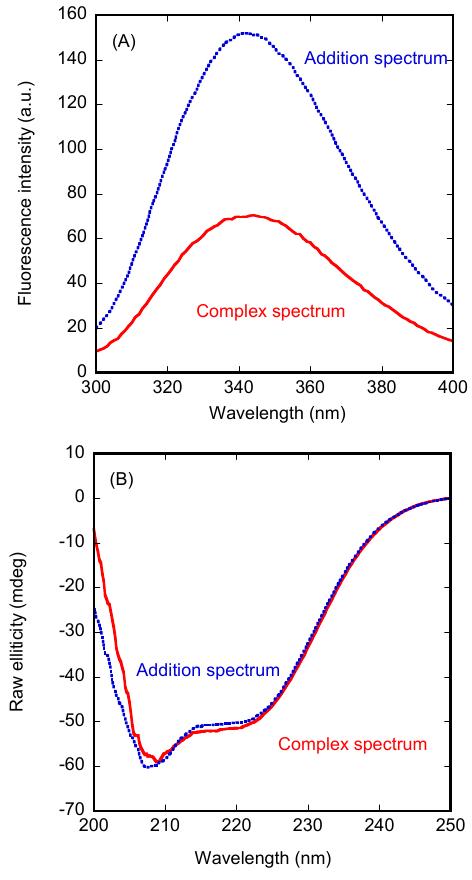
Figure 1. Binding of Imp α 3 to PADI4 as monitored by spectroscopic probes. ( A ) The spectrum of PADI4/Imp α 3 complex after excitation at 280 nm, and the addition spectrum obtained by the sum of those of the two separated macromolecules. ( B ) Far-UV CD spectrum of the PADI4/Imp α 3 complex, and the addition spectrum. All experiments were performed at 25 °C.